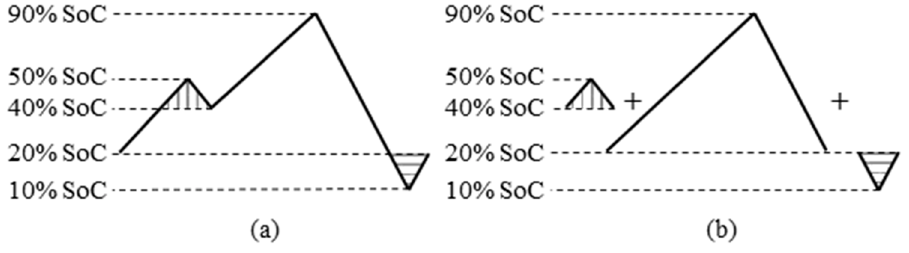
Figure 3. Decoupling of the charging and discharging cycles [22]: ( a ) original cycles, and ( b ) decoupled